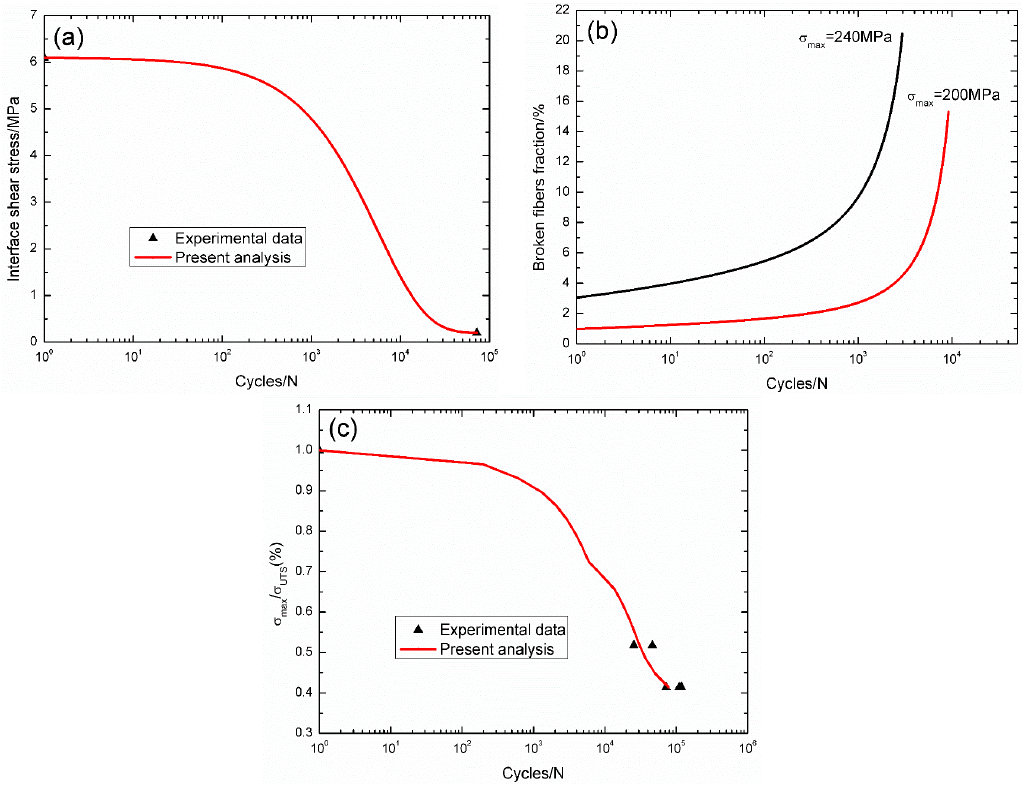
Figure 9. ( a ) The interface shear stress versus applied cycles; ( b ) the broken fibers fraction versus applied cycles; and ( c ) the fatigue life S–N curves of experimental data and theoretical analysis for unidirectional C/SiC composite at 800 °C in air. Table 2. The material properties of unidirectional (UD), cross-ply (CP), 2D, 2.5D and 3D C/SiC composites at elevated temperature.